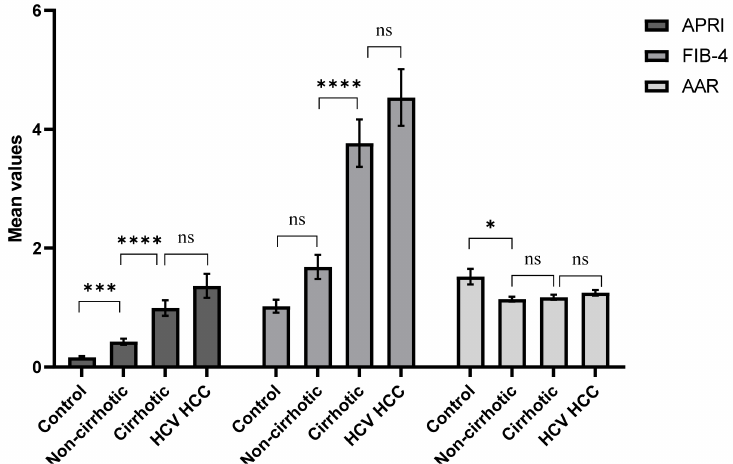
Figure 4. Mean values of the non-invasive indices APRI, FIB-4, and AAR in the study groups. Comparison of the statistical significance of the three non-invasive indices in differentiation between different disease stages. Values are expressed as mean ± SEM. Statistical significance (**** indicates p ≤ 0.0001, *** indicates p ≤ 0.001, * indicates p ≤ 0.05, ns indicates non-significance). (AAR: AST